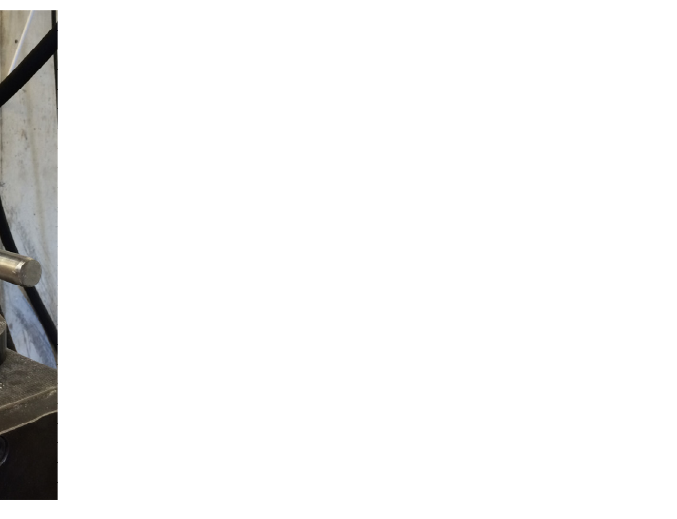
Figure 6. Camera captured the crack propagation on the surface of a reinforced specimen.